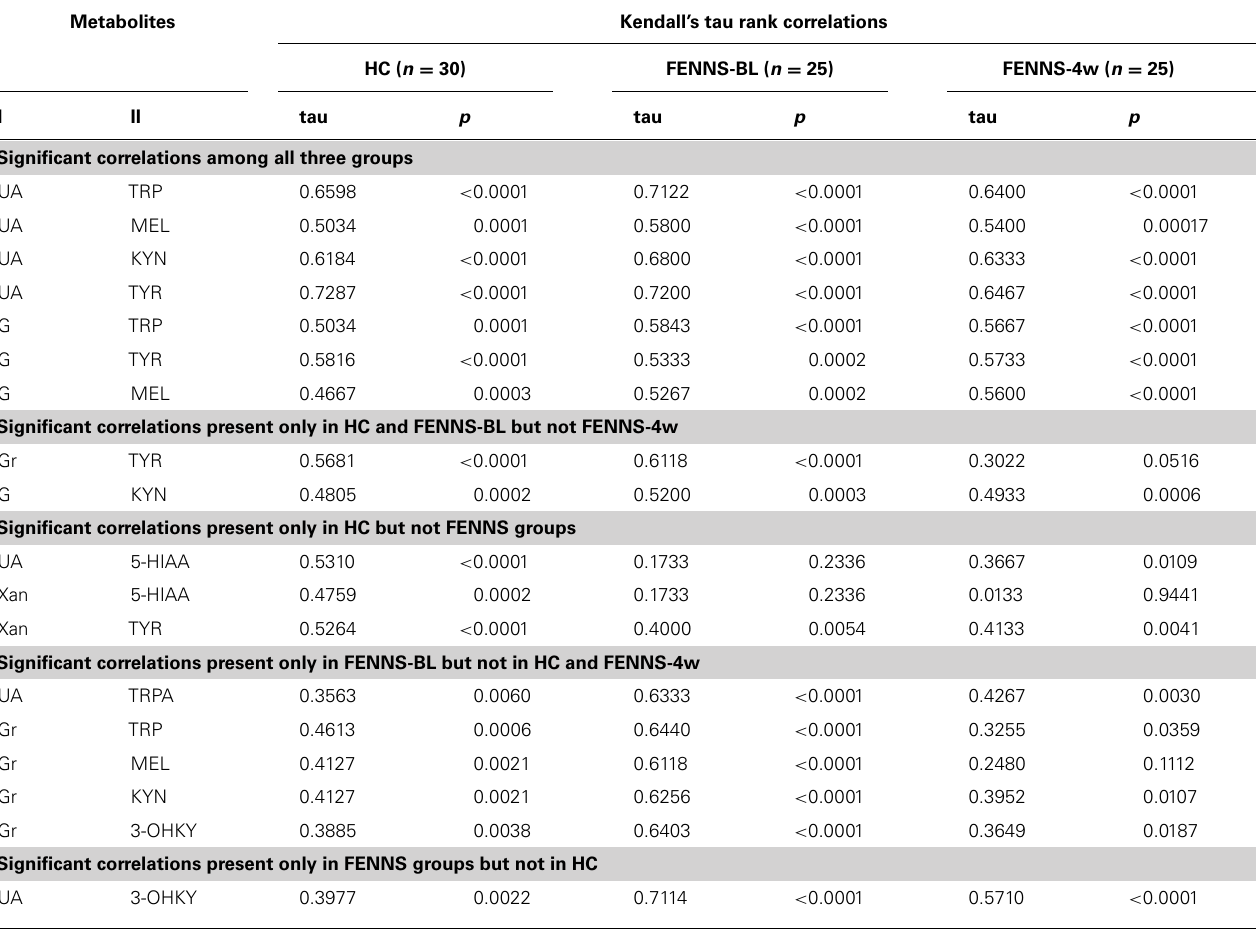
Table 2 |Across pathway correlations between 6 purine and 14 monoamine metabolites by the Kendall’s tau method.